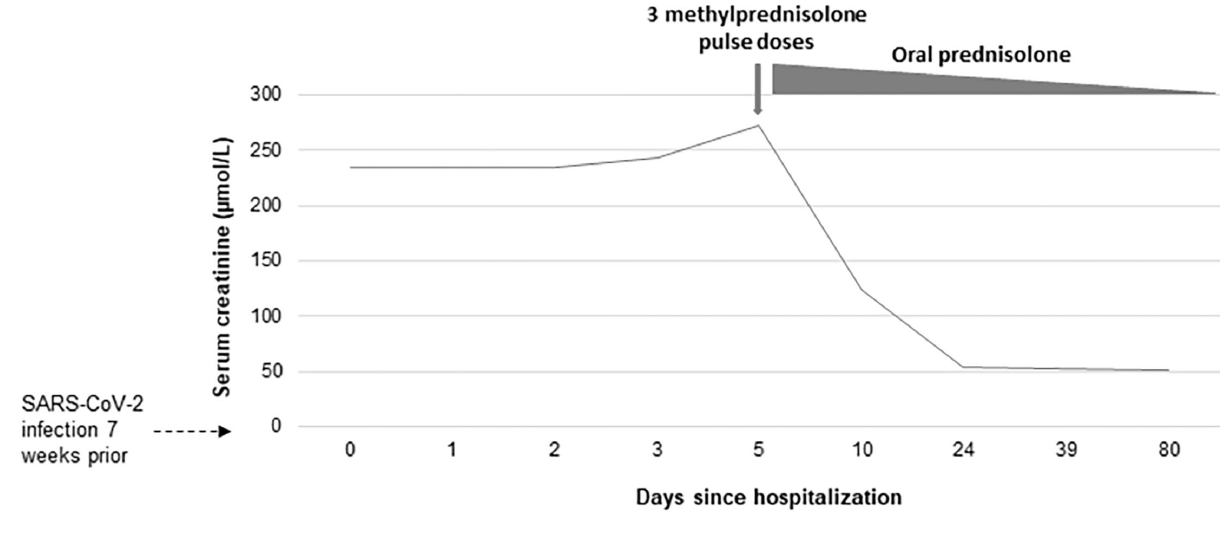
FIGURE 2 | Time course of serum creatinine since the admission to the